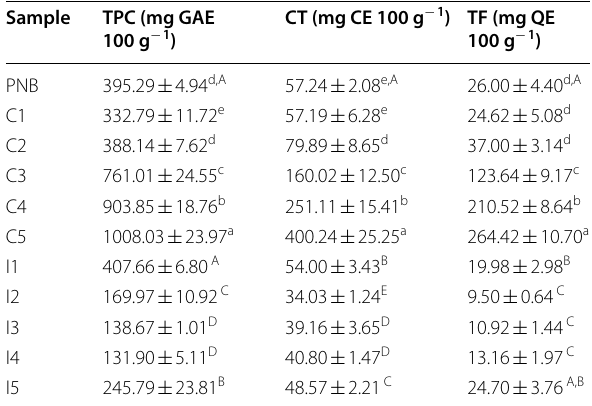
(PNB) and its concentrate (C1-C5) and ice (I1-I5) fractions over a five-stage block freeze